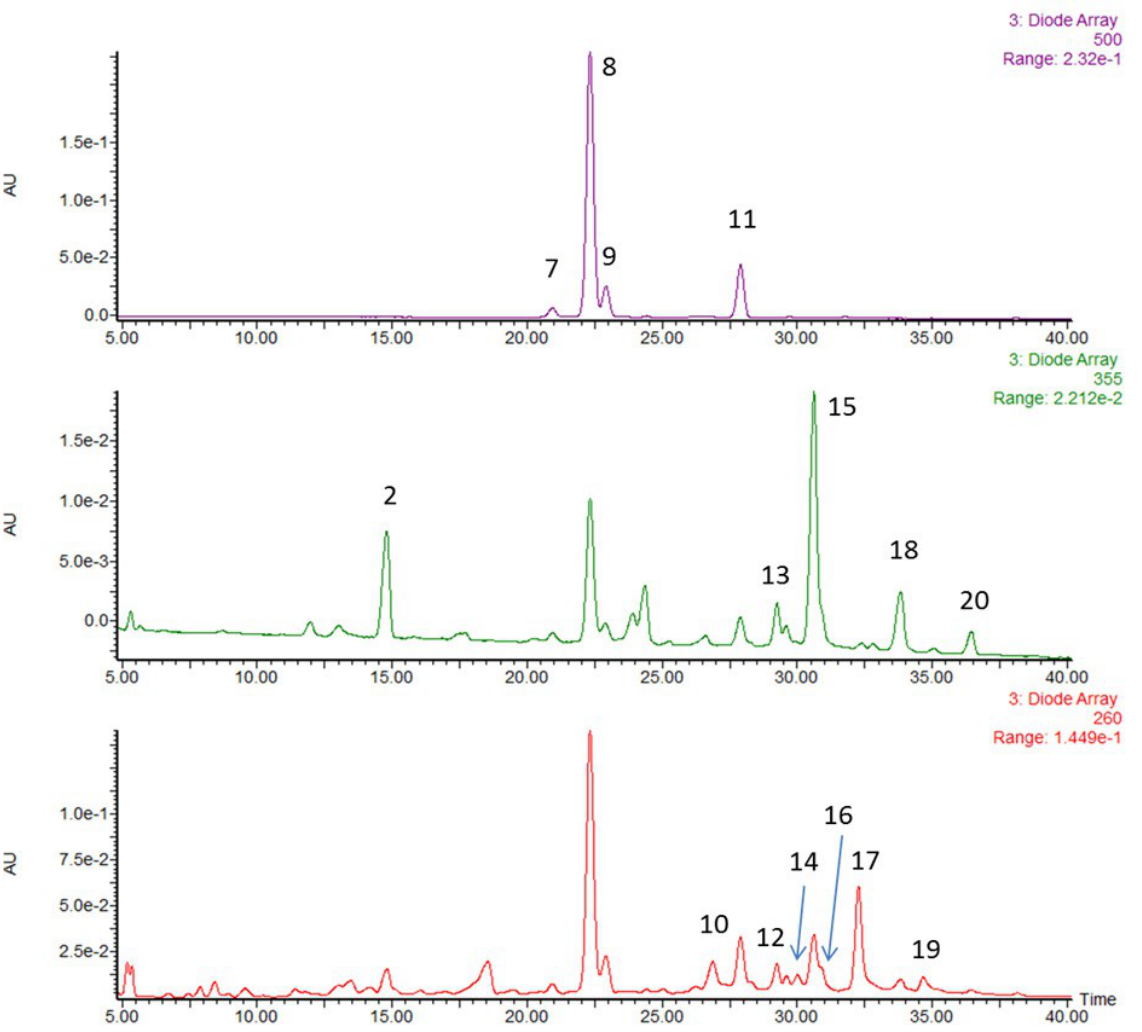
Figure 1. High performance liquid chromatography (HPLC) chromatogram of strawberry extract separated on Zorbax SBCN 4.6 × 250 mm, 5 µm column with 1% (v/v) formic acid in water versus 1% (v/v) formic acid in acetonitrile mobile phase gradient. The peak identities were established using accurate mass MS results as well as UV-vis features and literature precedent for strawberry analysis. Table 2. Bioactive phenolic compounds identified in lyophilized strawberries. Peak